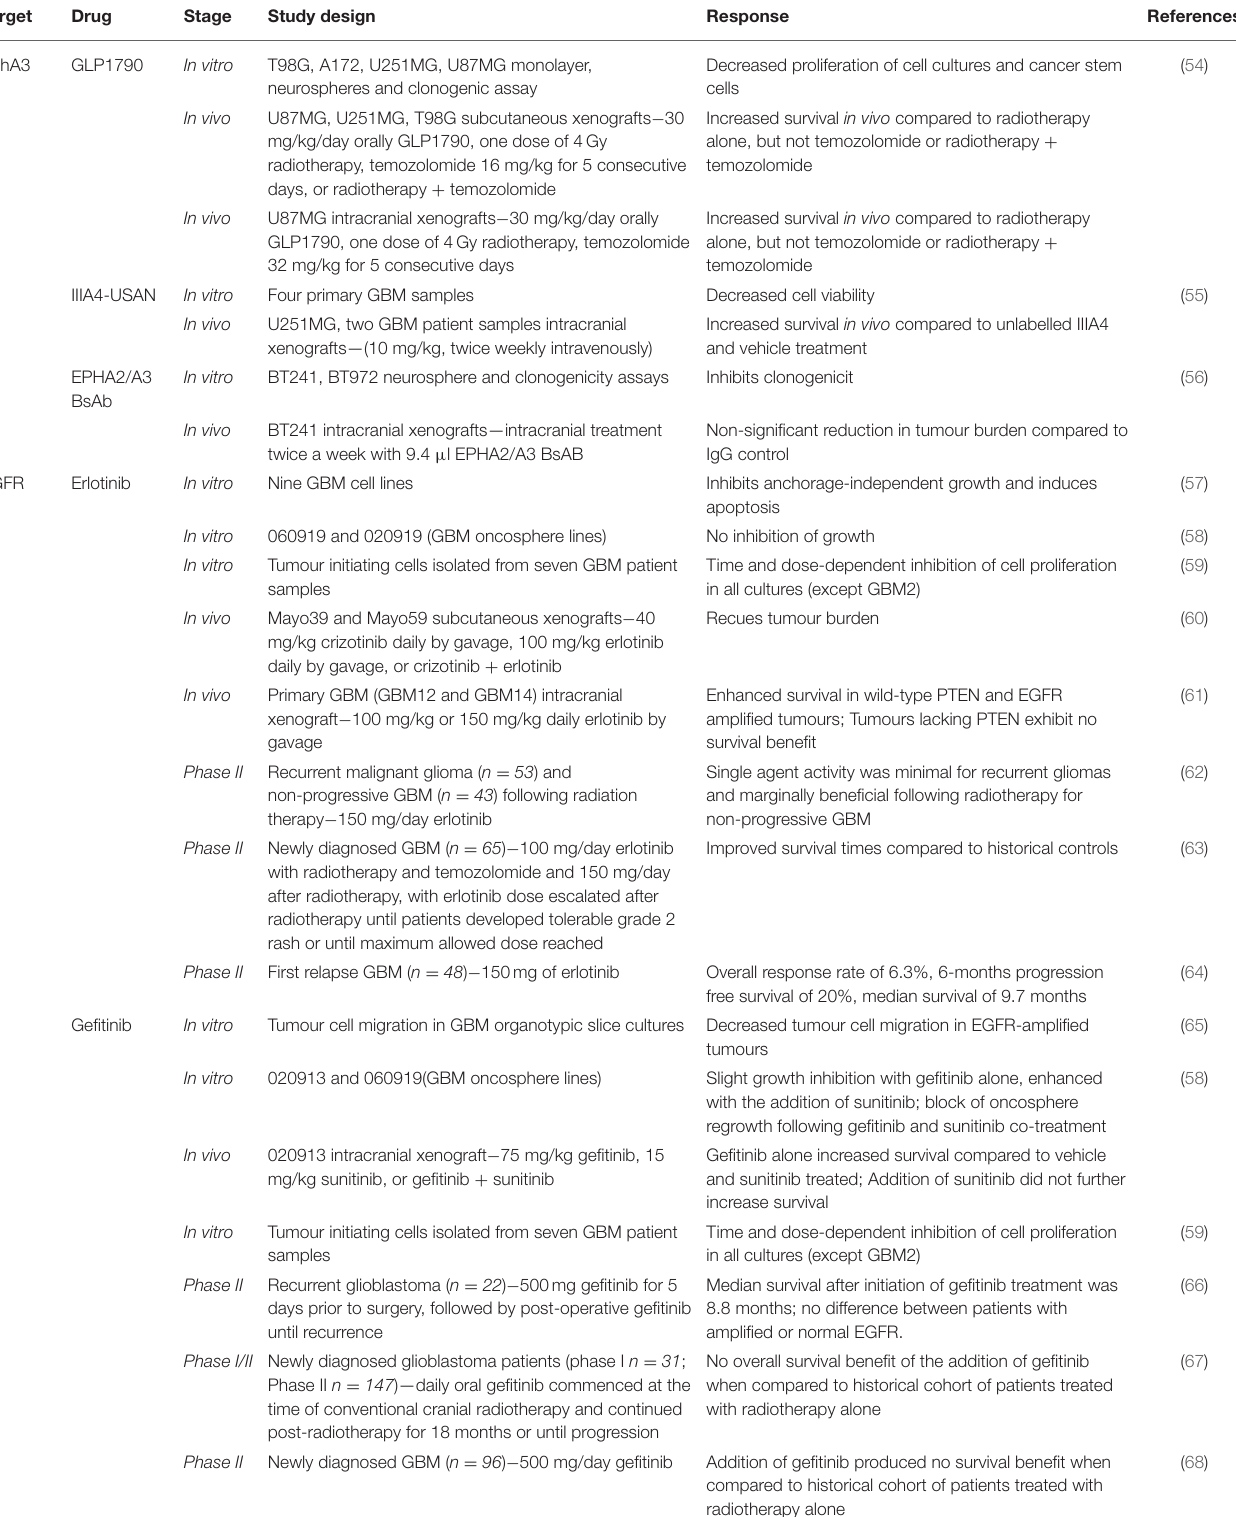
TABLE 2 | Targeted therapeutic outcomes in GBM.